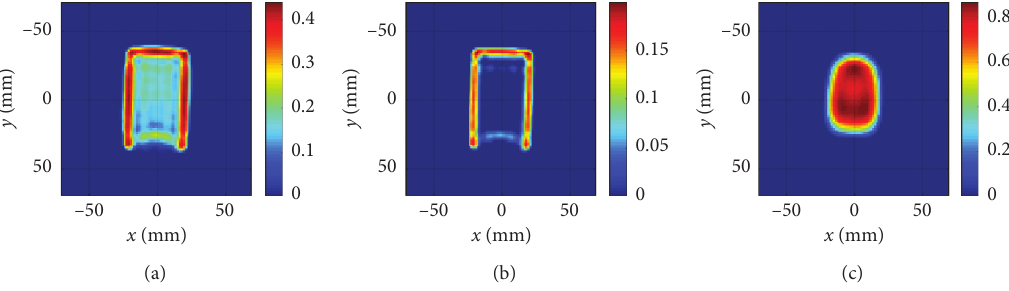
Figure 2: The imaging results of “ U -shaped” groove.